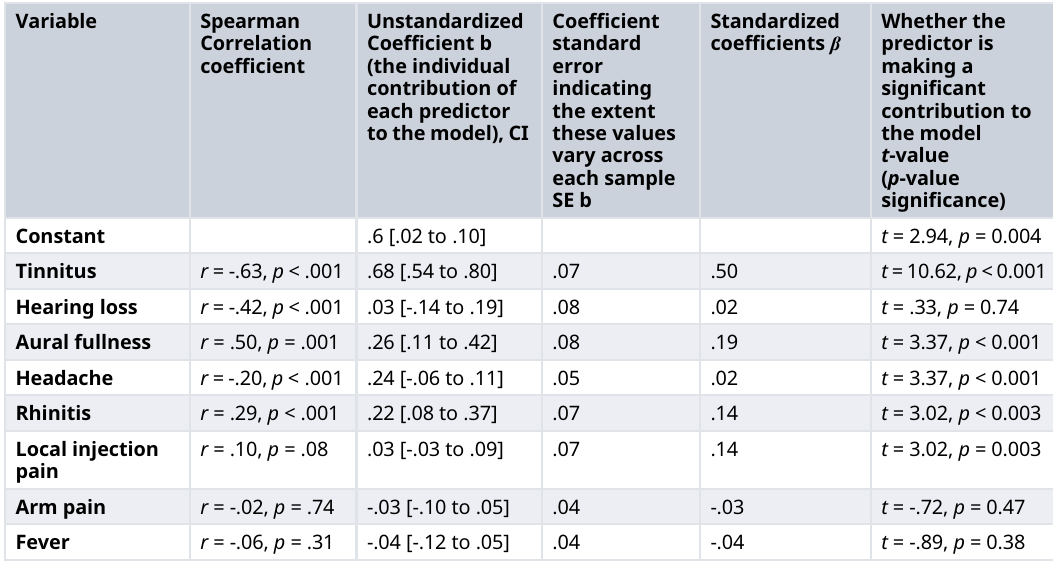
Table3.Hierarchicallinearmultipleregressionmodelwithpost-vaccinationvertigo-relatedsymptomsasthe dependent variable and other post-vaccination adverse effects (e.g., tinnitus, hearing loss, headaches) as predictor variables. Significant results are represented by p =